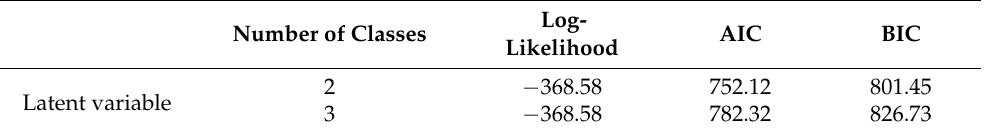
Table 2. Goodness of fit measurements for 2-class and 3-class models.